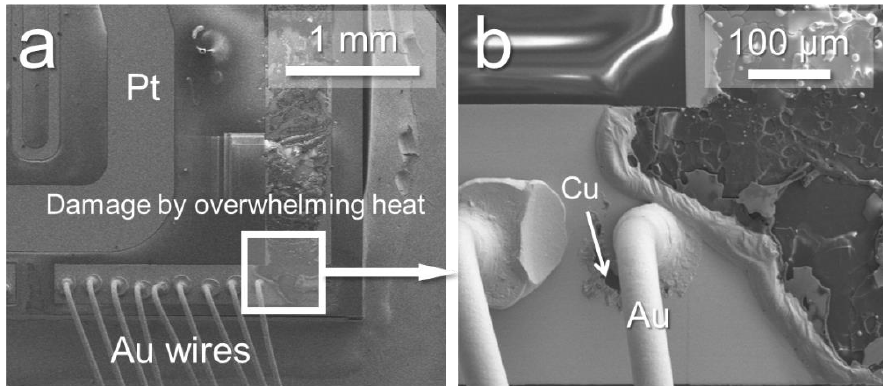
Figure 8. Pt heater pattern line was partly broken ( a ) and its magnified view ( b ).